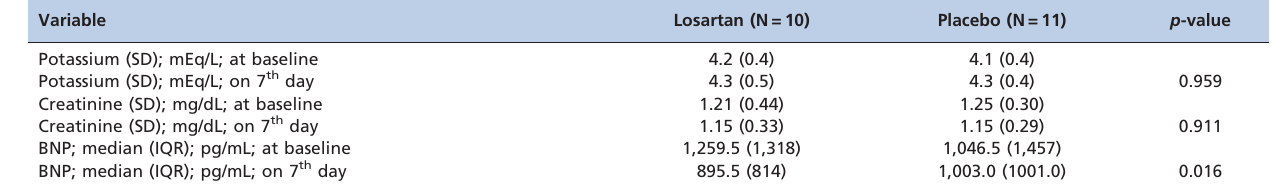
Table 2 - Changes in variables.